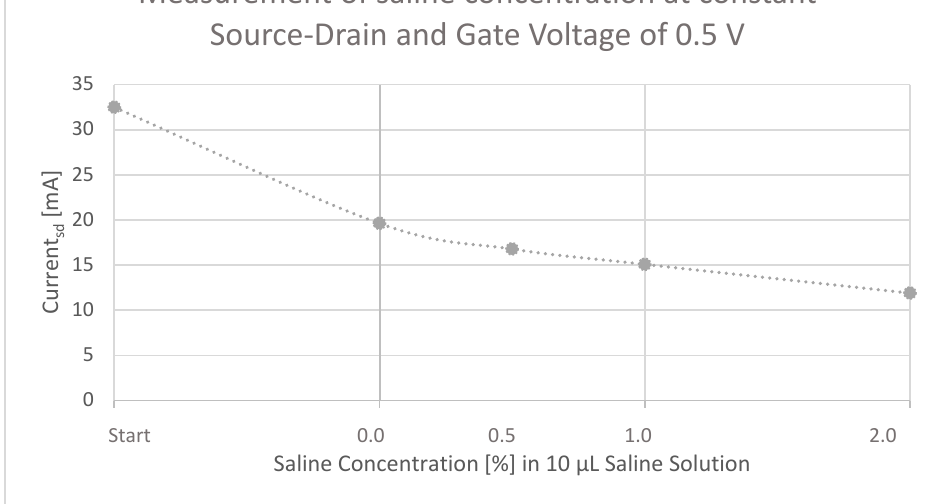
Figure 14. Measurement of different saline concentrations (0 – 2.0%) at constant source/drain and gate voltage of 0.5 V, showing that the OECT device is not only able to detect but also to measure saline concentration.